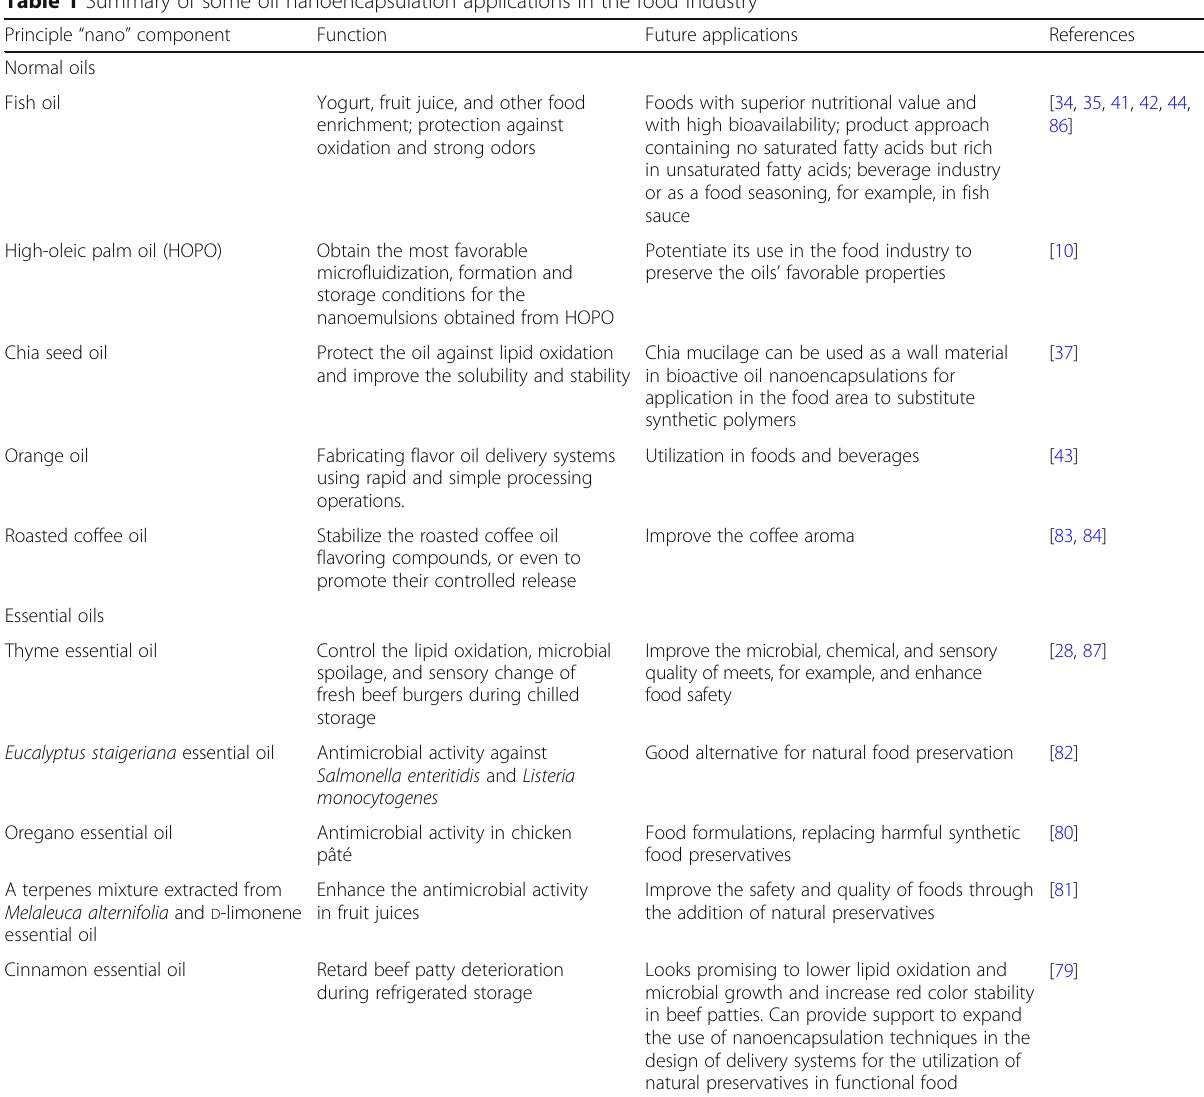
Table 1 Summary of some oil nanoencapsulation applications in the food industry Principle “ nano ”